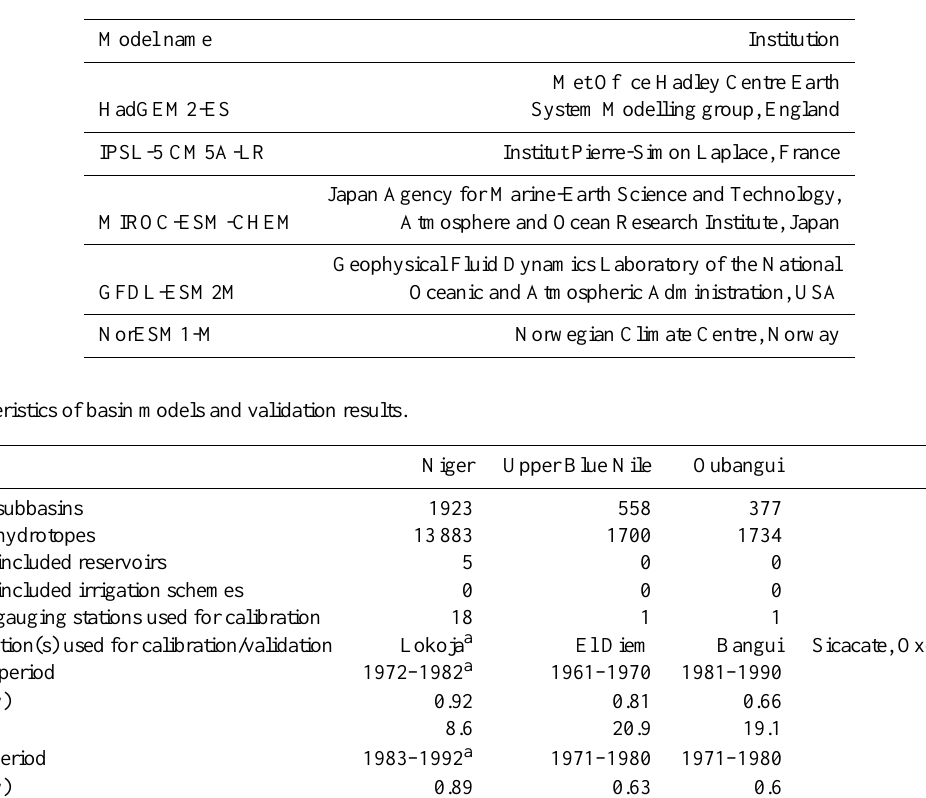
Table 2. Earth system models driving the SWIM model.